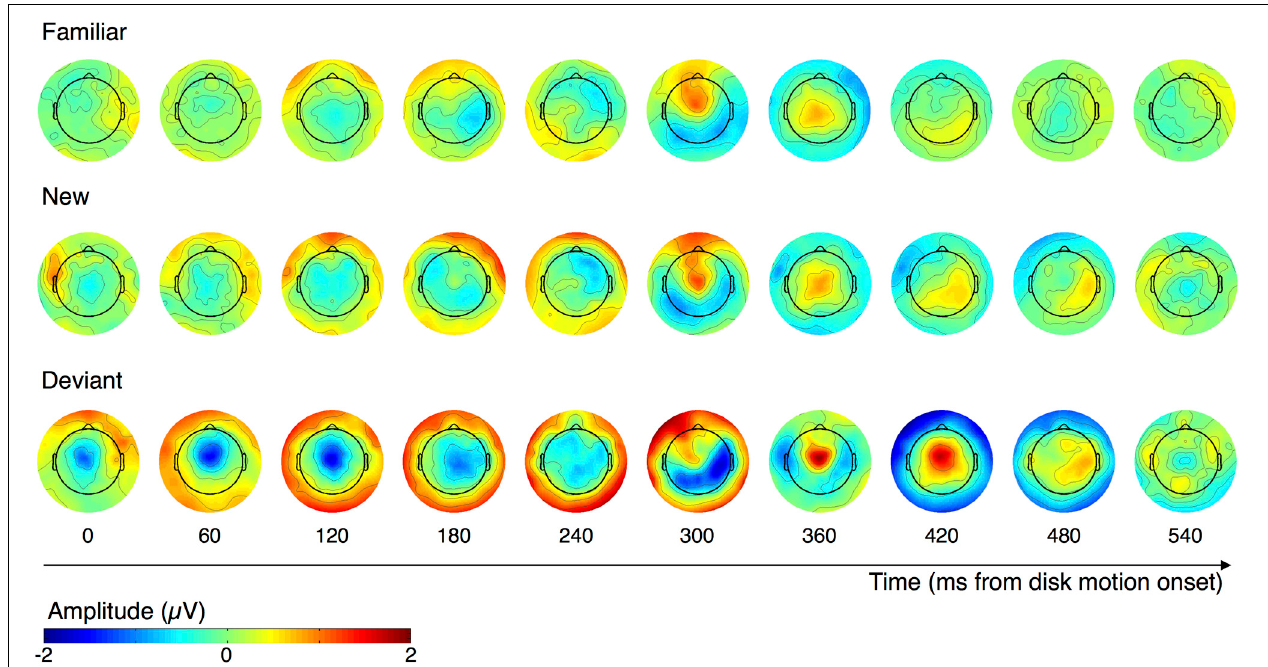
FIGURE 4 | Topographical plots of ERP amplitude across the scalp, over the course of familiar, new, and deviant motion segments. Each plot shows the mean distribution of voltage during the 60ms window centered on its labeled time point.